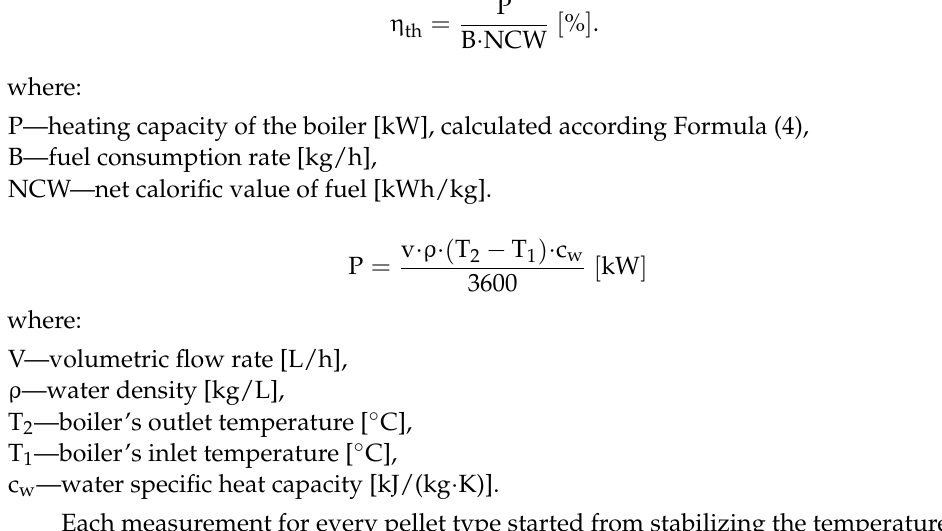
Figure 3. Tested boiler on the testing stand.